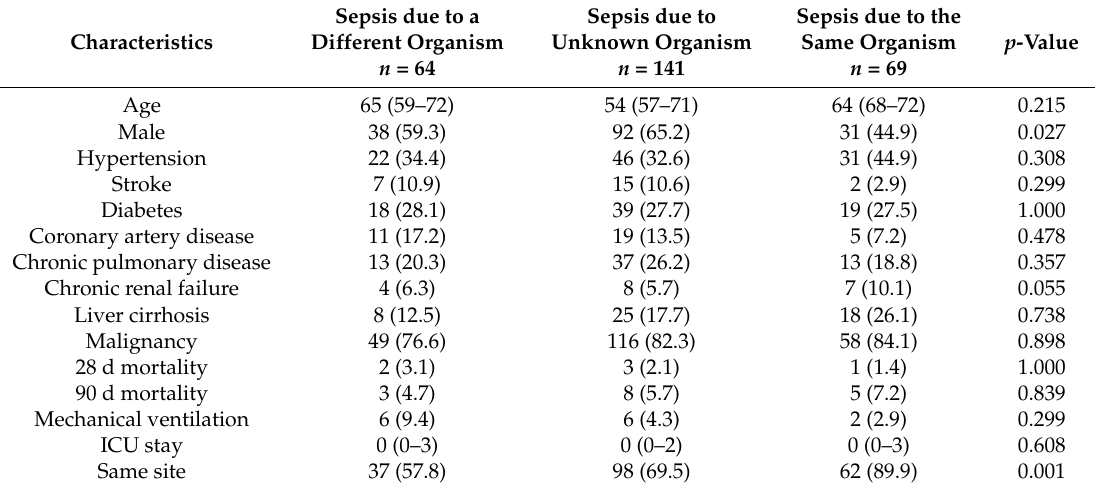
Table 1. Characteristics of Patients with Recurrent Sepsis